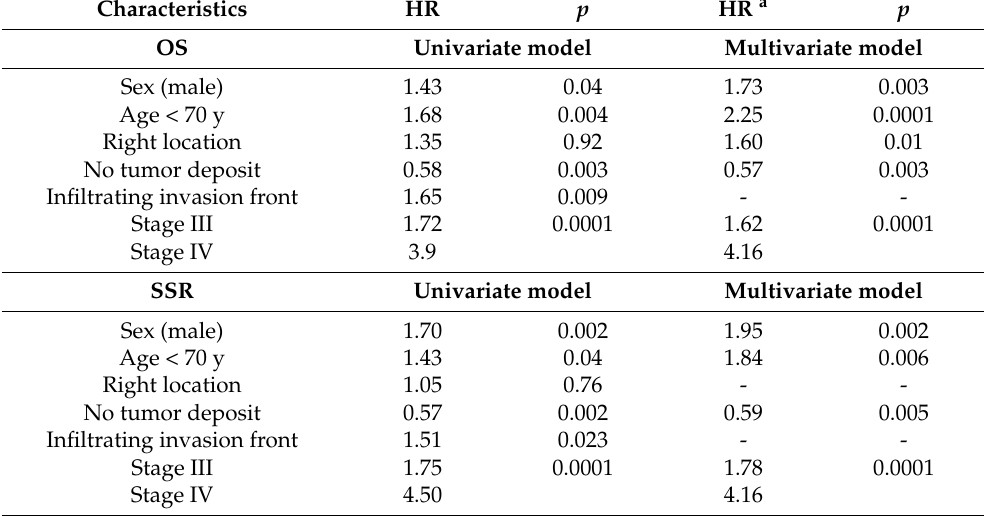
Table 4. Evaluation of the impact of clinical and histological prognostic factors on overall (OS) and recurrence-free survival (SSR) of the patients studied, according to a Cox model. Stages were evaluated without considering N1c staging to keep tumor deposits as an independent